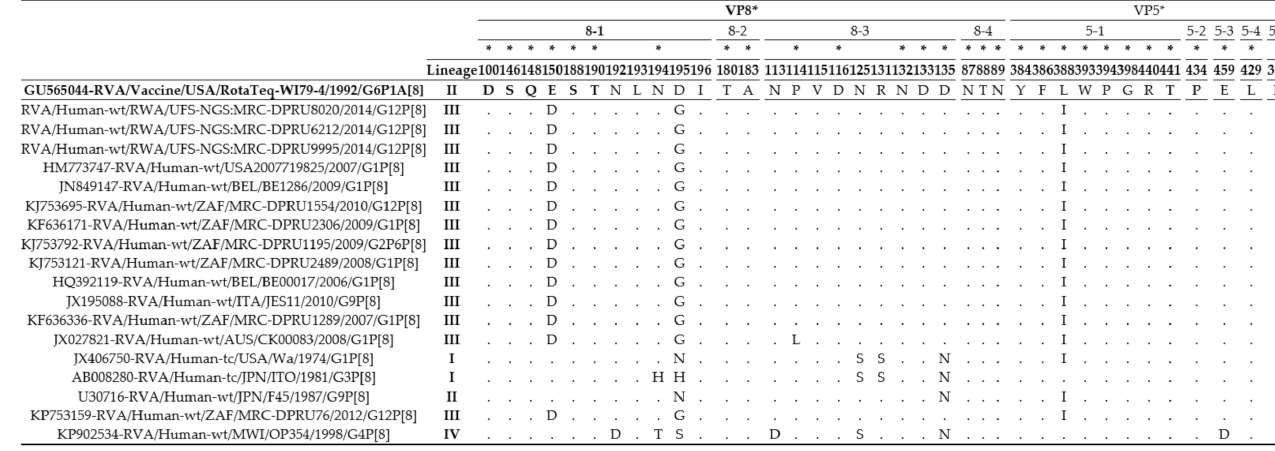
Figure 2. The alignment of the P[8] VP4 component of the Rotateq vaccine strain and P[8] Rwandan study strain based on the two VP4 domains, the VP8* (8-1 to 8-4) and VP5 (5-1 to 5-5). The asterisk (*) represents amino acid position of residues associated with escape neutralization with monoclonal